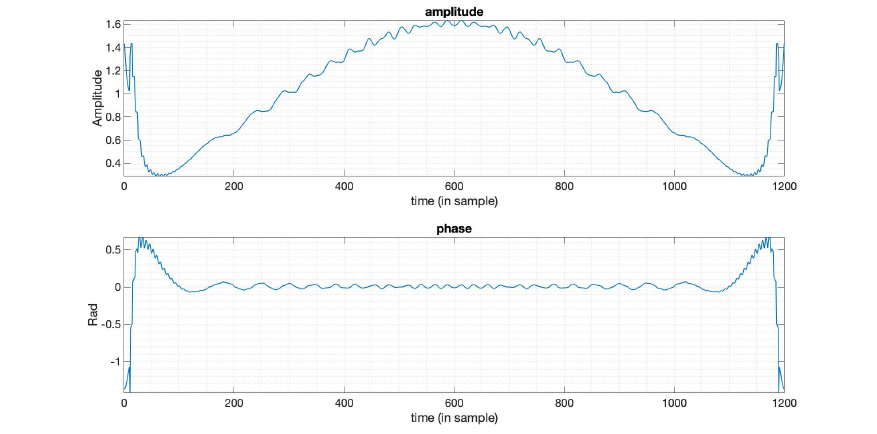
Figure 2. The amplitude and phase of the optimized window function in Figure